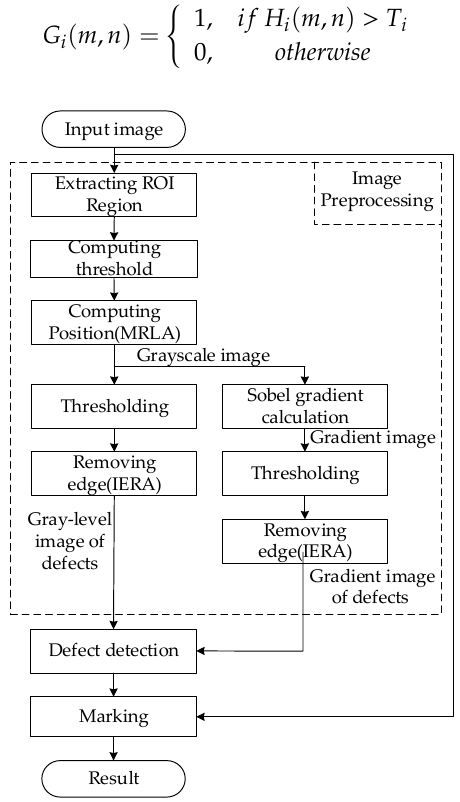
Figure 7. Flow diagram of the image processing.